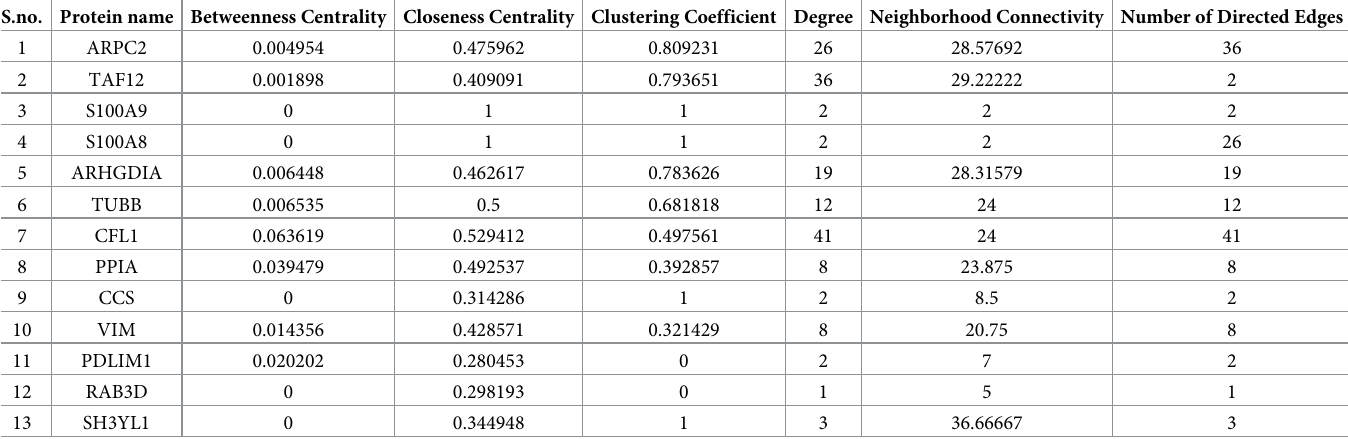
Table 6. Node data analysis using network analyser 4.4.5 from Cytoscape